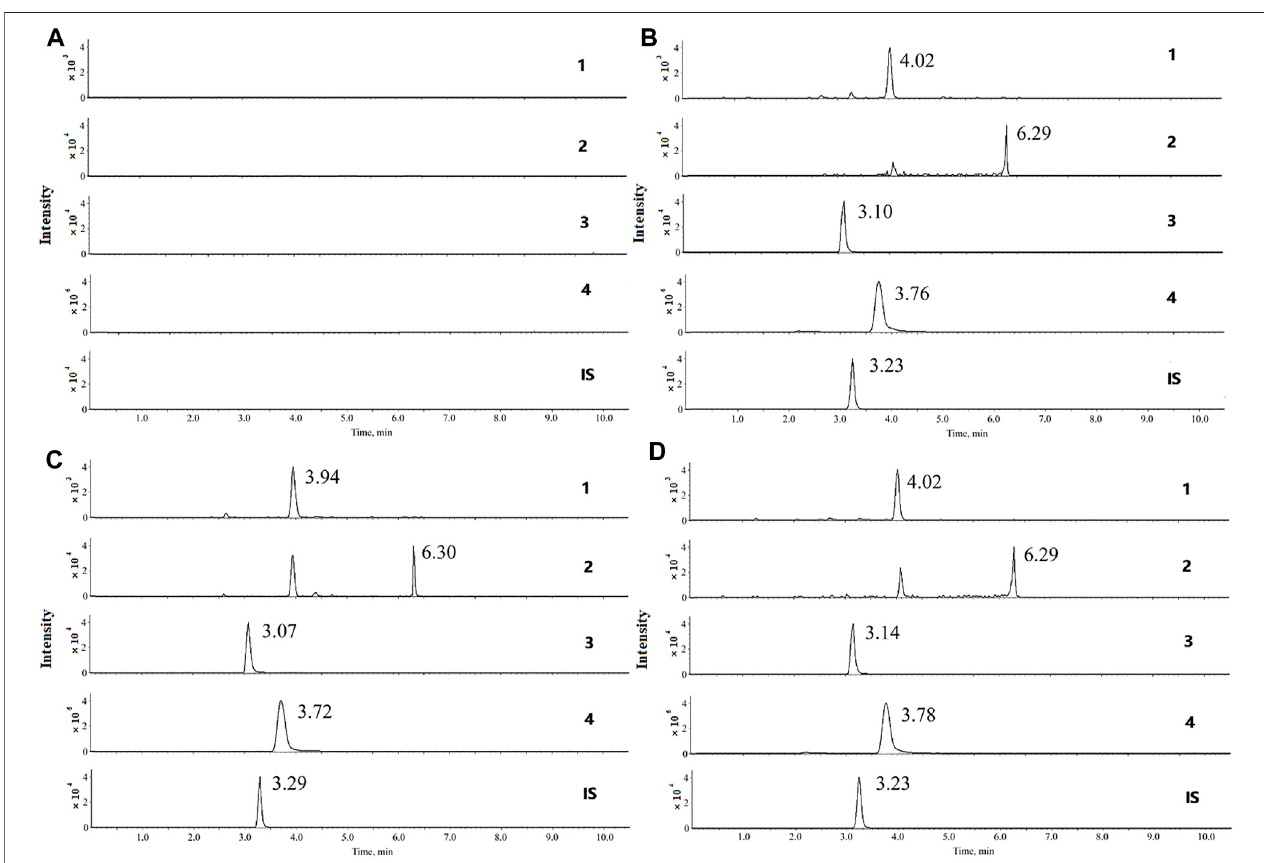
FIGURE 2 | Multiple reaction monitoring (MRM) chromatograms of the four compounds and chloramphenicol (IS) in rats. (A) blank serum; (B) blank serum with standard substance and IS; (C) serum of control group; (D) serum of UC group. 1 andrographolide, 2 dehydroandrographolide, 3 1-methoxicabony- β -carboline, 4 4- methoxy-5-hydroxy-canthin-6-one, and chloramphenicol ( IS ).